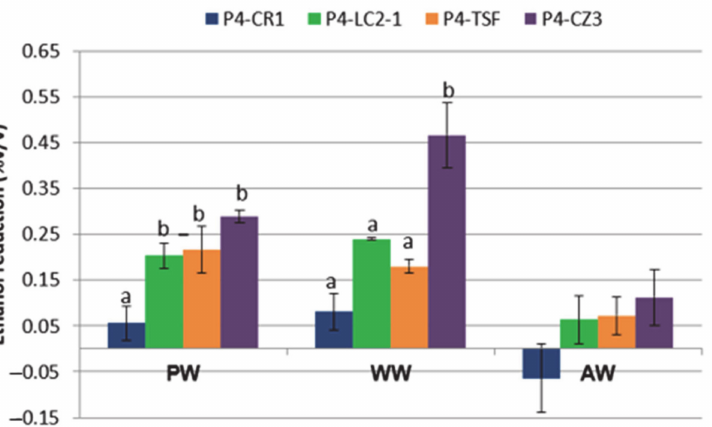
Figure 3. Alcohol reduction in the beers produced by the mixed cultures (P4-CR1, P4-LC2-1, P4-TSF, P4-CZ3) in the three different worts (PW, WW, AW). These values were calculated as difference between the alcohol content in beers obtained from each mixed starter and the ethanol content of beer obtained with the pure starter (P4). Data with different superscript letters (a, b) within each trial are different according to Tukey’s test ( p ≤